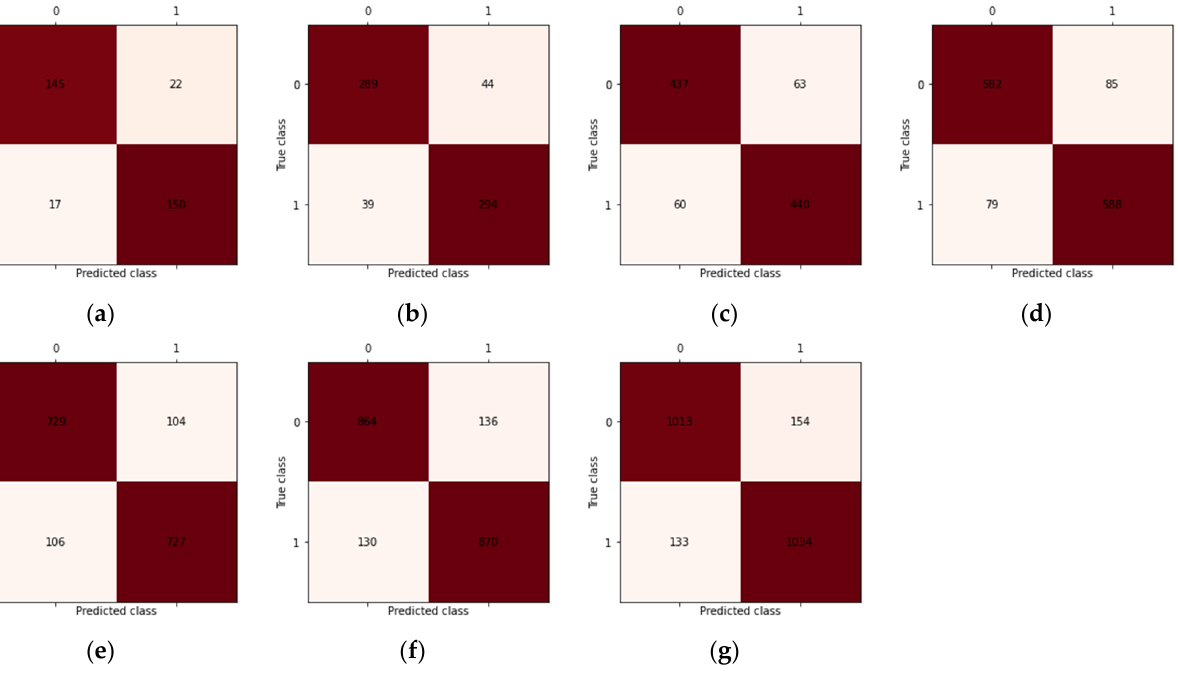
Figure A1. The confusion matrix of the S_W2_NB: ( a ) the dimension of 1000; ( b ) the dimension of 2000; ( c ) the dimension of 3000; ( d ) the dimension of 4000; ( e ) the dimension of 5000; ( f ) the dimension of 6000; ( g ) the dimension of